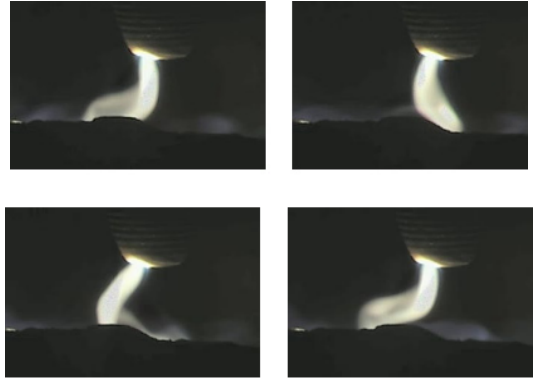
6 of 22 Figure 5. Schematic visualization of the effects of the arc shift between the hollow graphite electrode (HGE) and the steel bath on the thermal profile in hydrogen plasma smelting reduction (HPSR) processes.